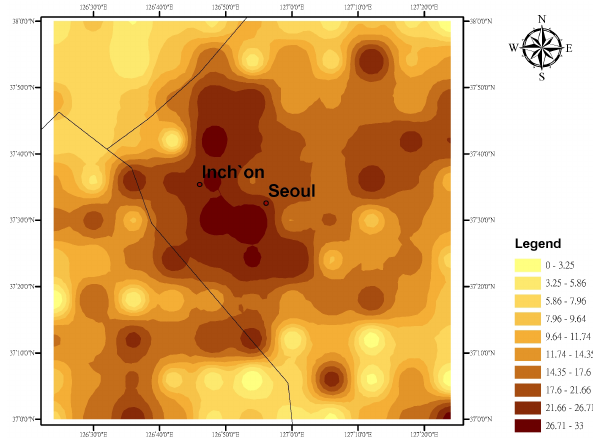
Fig. 2. Spatial distribution of negative flash density (flkm − 2 yr − 1 ) over Seoul for the years 1989–1999.